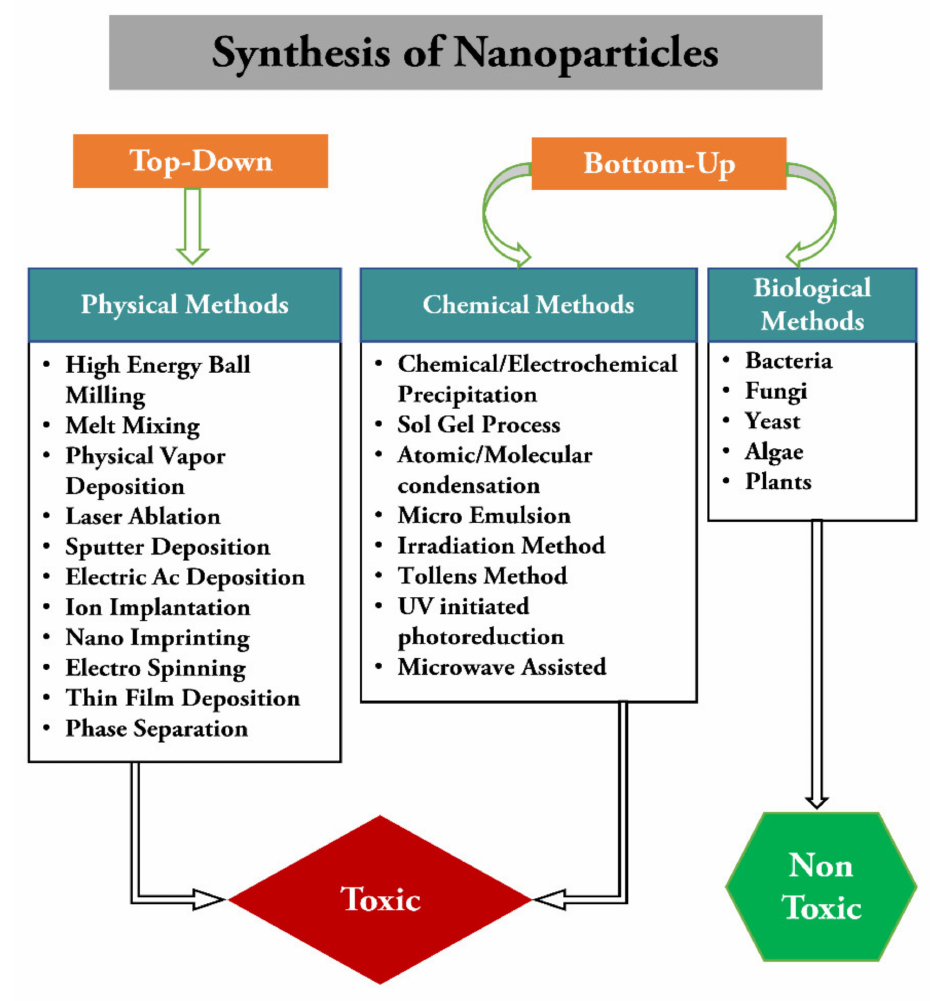
Figure 1. Different types of method used for the synthesis of